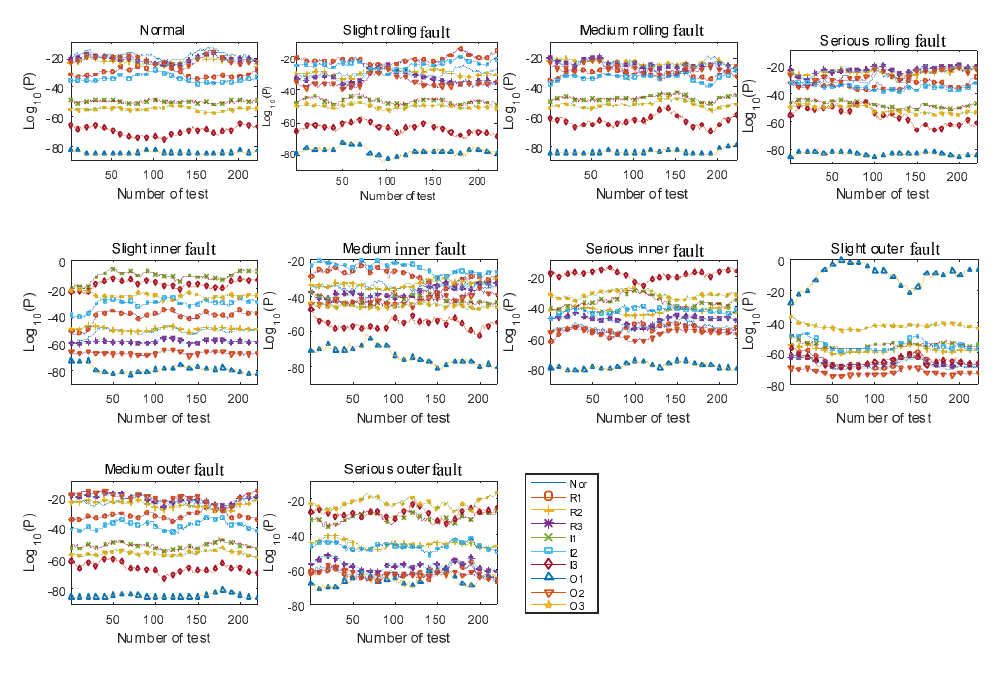
Fig. 5 Identification results of various fault states of bearing for every 30 observation